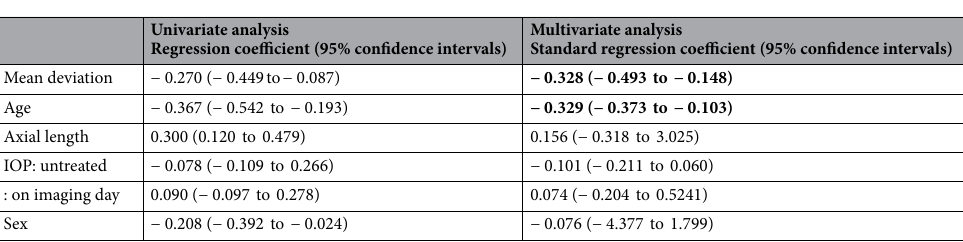
Table 2. Relationship between the position of the central retinal vessel on the ONH and possible confounders: Results of multiple regression analysis. In the multiple regression analysis, all variables indicated are used as independent variables. Significant coefficients are noted in boldface. ONH, optic nerve head; IOP, intraocular pressure. R 2 , contribution ratio was 0.270.